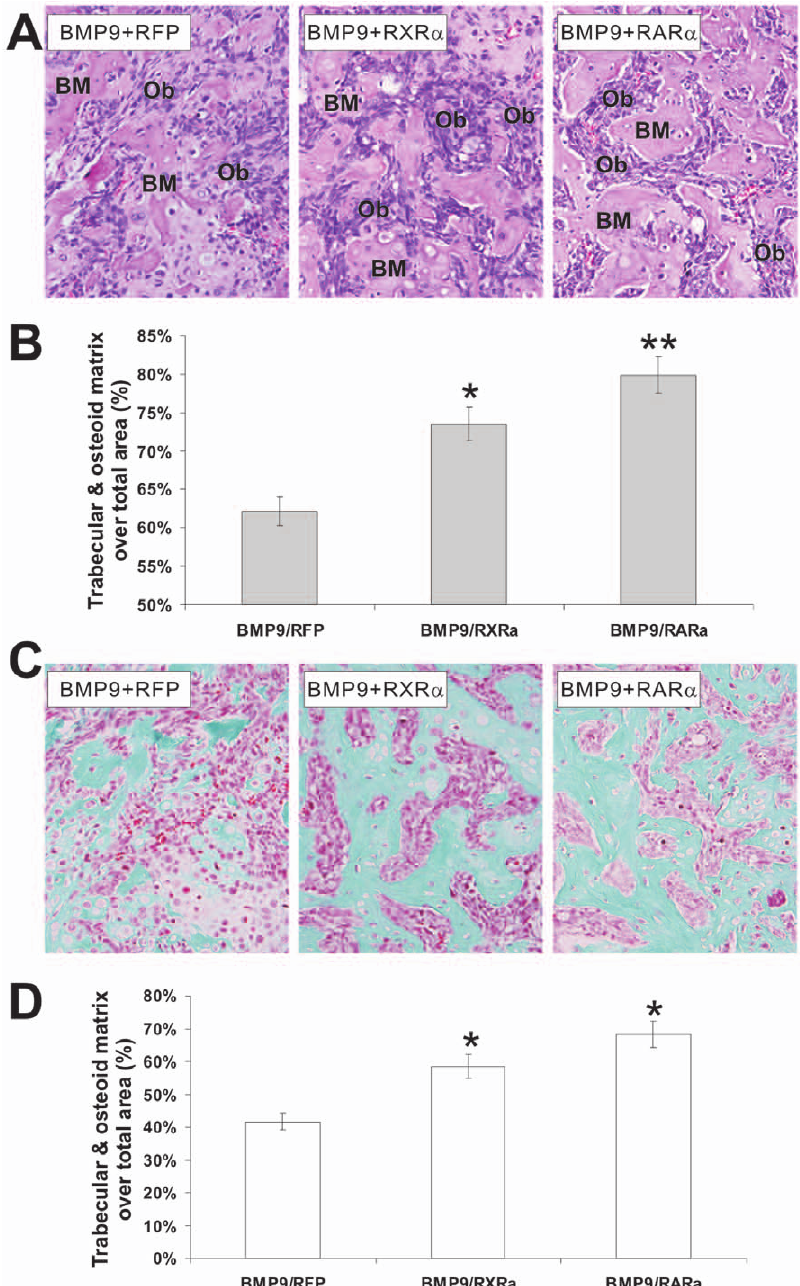
Figure 6. Retinoids enhance BMP9-induced ectopic ossification. ( A ) Histological evaluation of ectopic bone formation. Subconfluent MEFs were co-infected with AdBMP9 and AdRFP, AdR-RXR a , or AdR-RAR a adenoviruses (MOI=10) for 16 h. The infected cells were implanted subcutaneously (5 6 10 6 /injection) into the flanks of athymic nude (nu/nu) mice (5 mice/group, 4–6 week old, male, Harlan Sprague Dawley). At 4 wk after implantation, animals were sacrificed, and the implantation sites were retrieved, fixed and decalcified. The paraffin-embedded sections were subjected to H & E staining. Representative images are shown. BM, bone matrix (ossified and osteoid); Ob, osteoblast. ( B ) Quantitative analysis of trabecular and osteoid matrix area. The average trabecular bone and osteoid matrix areas were determined. At least 10 samples (with 6 100 magnification) from each group were randomly selected and analyzed by using ImageJ software. ‘‘*’’ p , 0.05 , ‘‘**’’ p , 0.001 . ( C ) Masson’s Trichrome staining of ectopic bone masses. Tissue sections prepared in were subjected to Masson’s Trichrome staining. Representative images are shown. Magnification, 6 400. ( D ) Quantitative analysis of % trabecular/osteoid area over total area was done by using ImageJ. At least 10 samples (with 6 100 magnification) from each group were randomly selected and analyzed. ‘‘*’’ p , 0.01 .